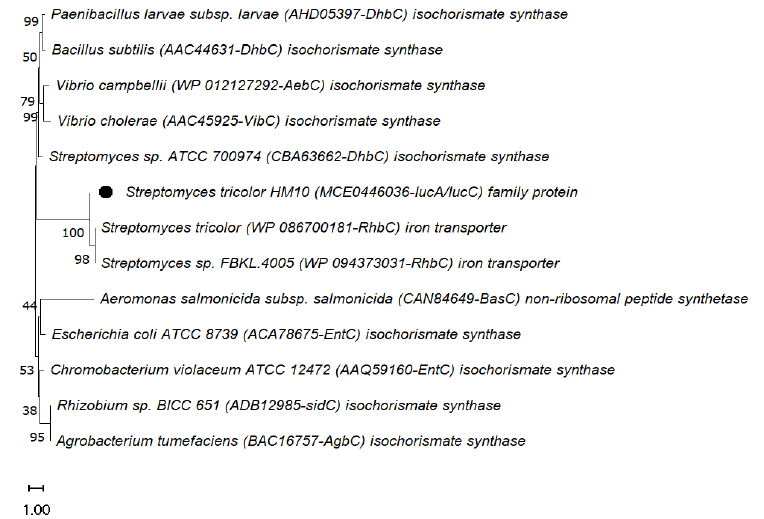
Figure 6. Constructed phylogenetic tree of the proposed IucA/IucC family protein in the S. tricolor HM10 catechol pathway with 12 protein sequences from other bacteria. The dendrogram was generated by the maximum likelihood, Jones–Taylor–Thornton (JTT) model, and nearest-neighbor-